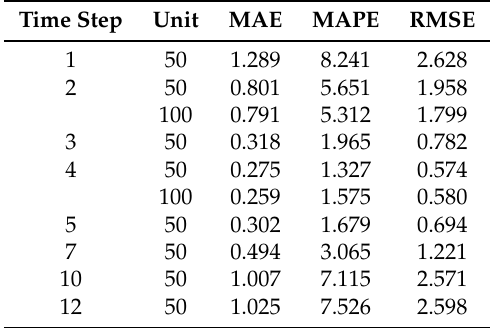
Table 4. Prediction performance over time